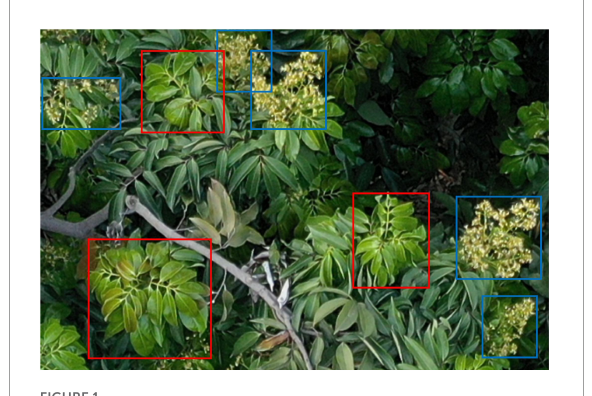
FIGURE1 Flower clusters and flushes during the litchi flowering